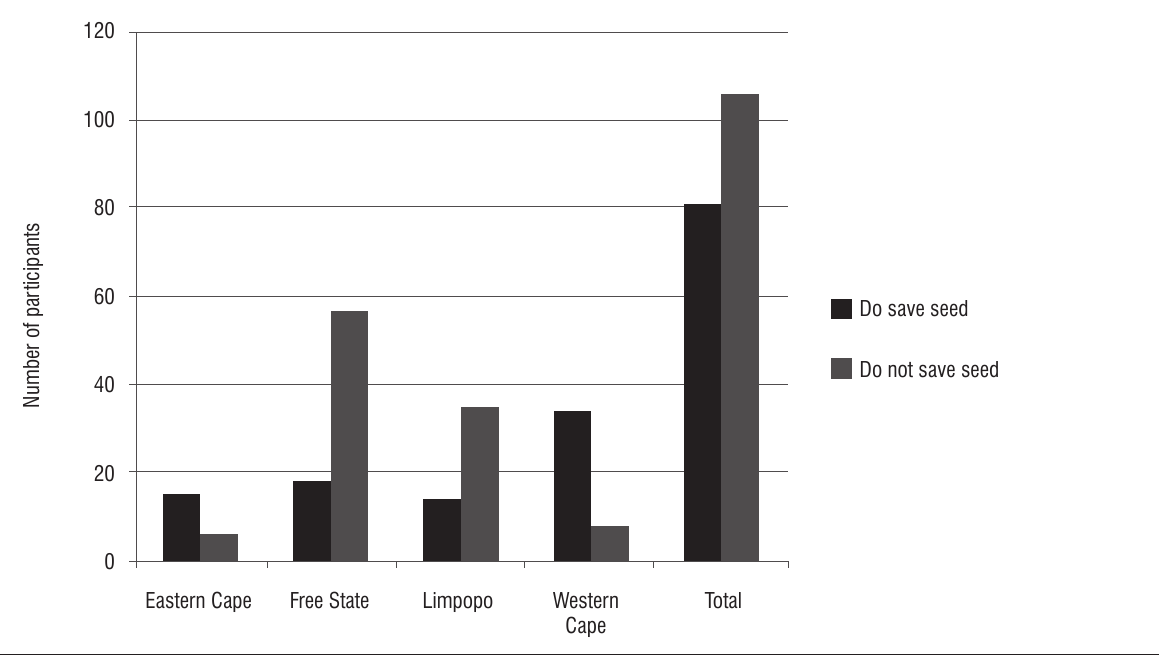
Figure 2: Practice of saving seed among participants from different